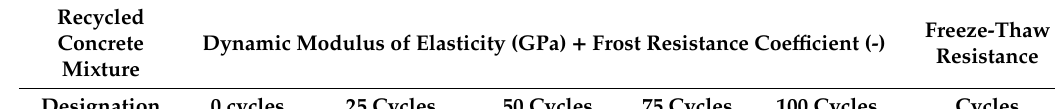
Table 5. Dynamic modulus of elasticity measured by ultrasonic method and frost resistance coe ffi cient determined from the dynamic modulus of elasticity after freezing and thawing